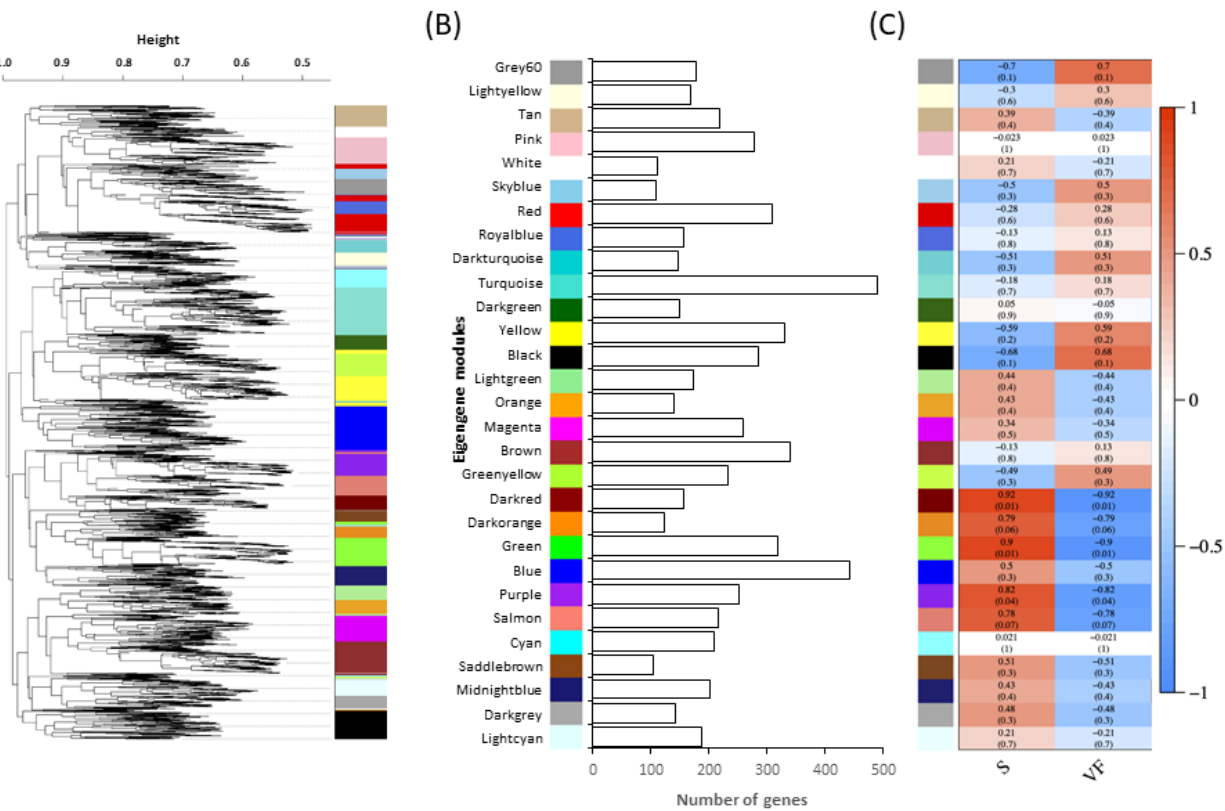
Figure 2. Weighted gene co-expression network analysis (WGCNA) of the fungal component of the Ulmus americana - Ophiostoma novo-ulmi ssp. americana interactome. ( A ) Cluster dendrogram showing the genes (branches) and co-expressed modules (colors); genes were clustered in 29 modules according to 1-TOM soft threshold. ( B ) Number of eigengenes per module. ( C ) Module traits in O. novo-ulmi in planta. The colour scale (red-blue) for relationships between module eigengenes (rows) and treatments (columns) represents the strength of the correlation (1 to − 1). Modules Darkred ( p < 0.01), Green ( p < 0.01) and Purple ( p < 0.05) were associated with higher gene expression in susceptible (S) compared to resistant (VF) elm.